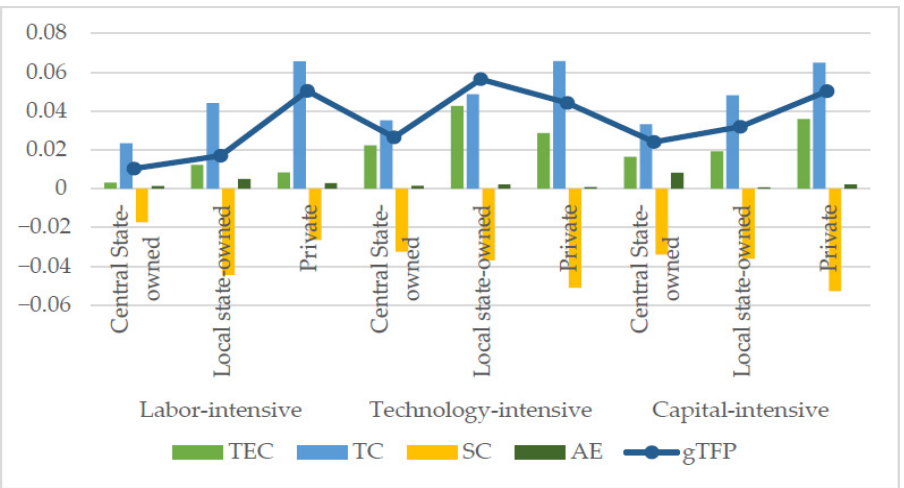
Figure 4. Bar chart of SFA decomposition results with regard to ownership enterprises of different industries.